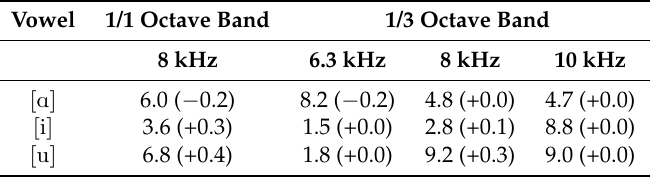
Table 2. HFE level mean increments (in dB) obtained for the simplified geometries with respect to the realistic ones. The values have been computed for the 8 kHz octave band and its corresponding 1/3 octave bands. The values in parentheses denote the additional increment in dB due to aspiration noise. Vowel 1/1 Octave Band 1/3 Octave